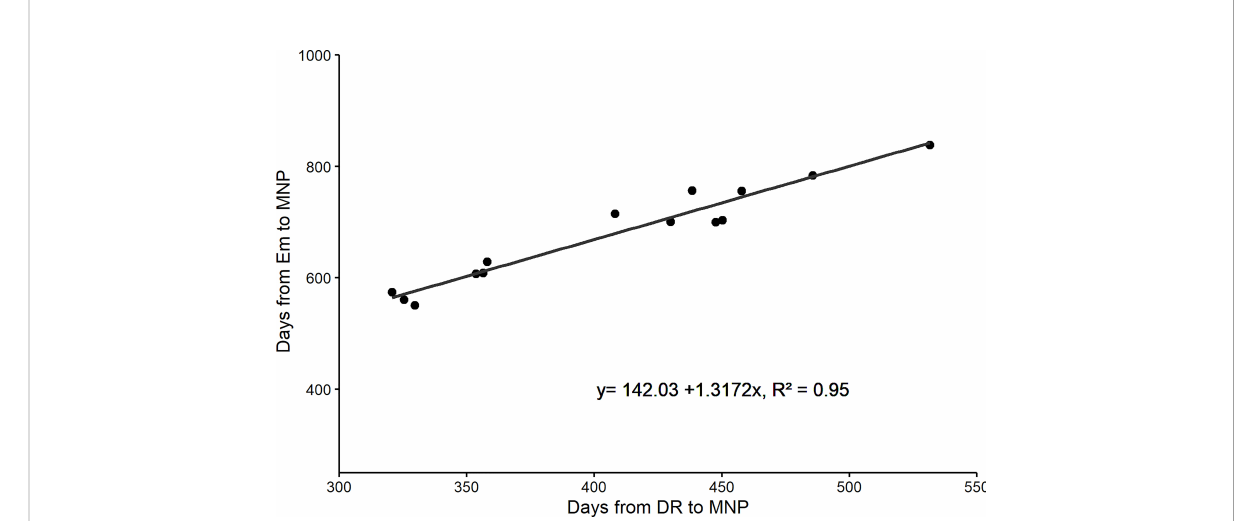
FIGURE 1 Relationship between days from emergence to Maximum number of spikelet primordia (MNP) and days from Doble ridge (DR) to MNP for fi ve cultivars of barley released at different eras in Brazil (FM 404-released in 1968, FM 434-released in 1977, BR 2-released in 1989, BRS 195- released in 2001, and BRS Elis-released in 2008). Data correspond to the experiments carried out in 2011, 2012, and 2013.